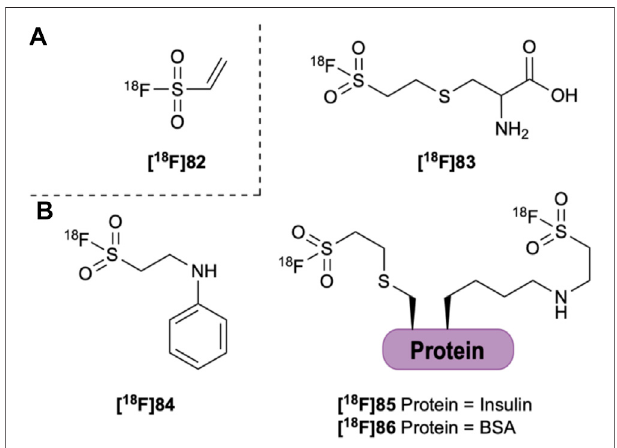
FIGURE 13 | (A) Ethenesulfonyl [ 18 F] fl uoride ( [ 18 F]82 ). (B) [ 18 F]82 can be conjugated to aniline ( [ 18 F]84 ) and the amine of several amino acids, the thiol of cysteine ( [ 18 F]83 ) and to insulin ( [ 18 F]85 ) and BSA ( [ 18 F]86 ).